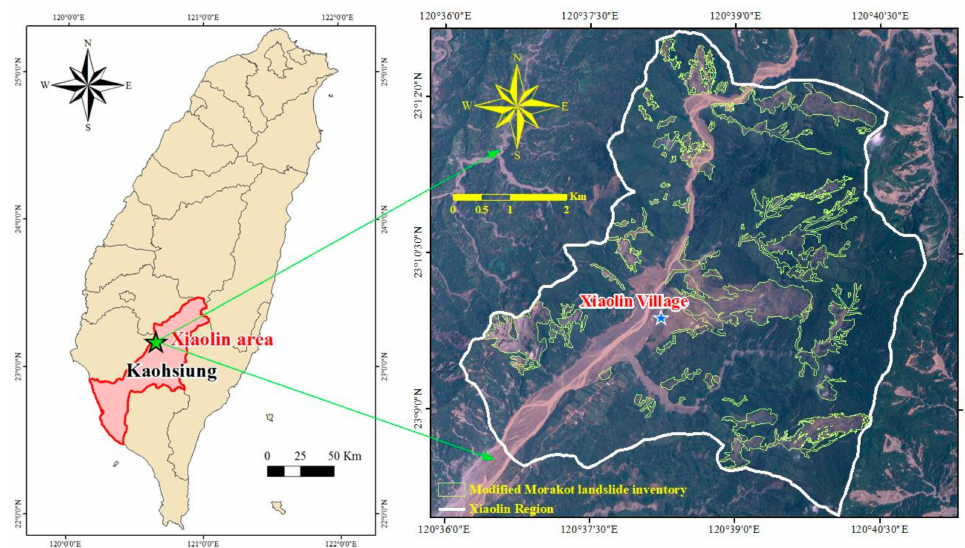
Figure 3. Typhoon Morakot landslide inventory for the Xiaolin area.